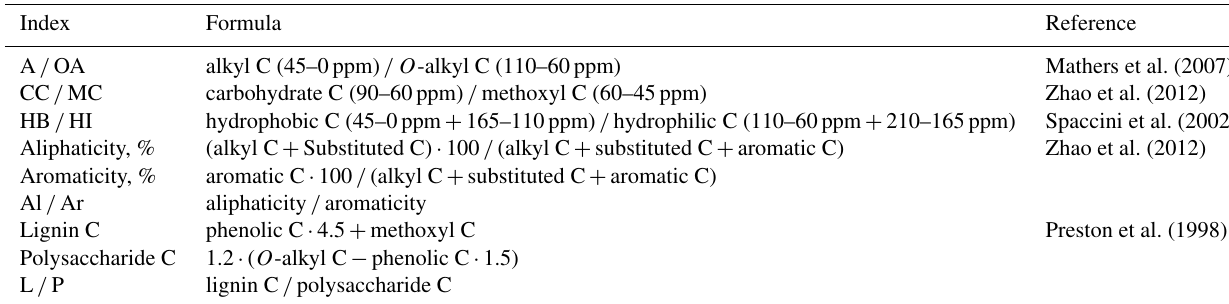
Table 1. Calculation formulas of different 13 C-NMR